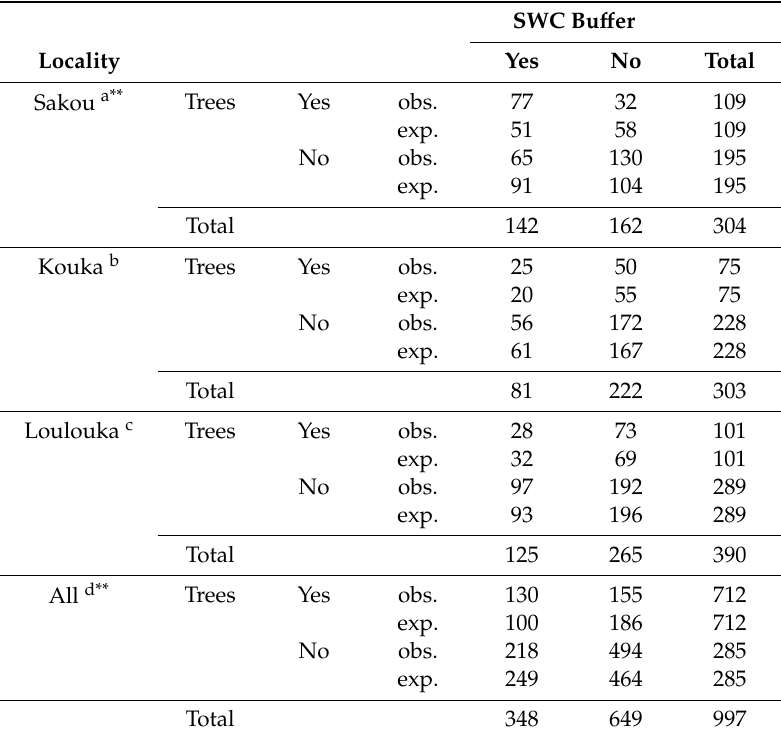
Table 3. Cross-tabulation of villages, SWC, and the presence of